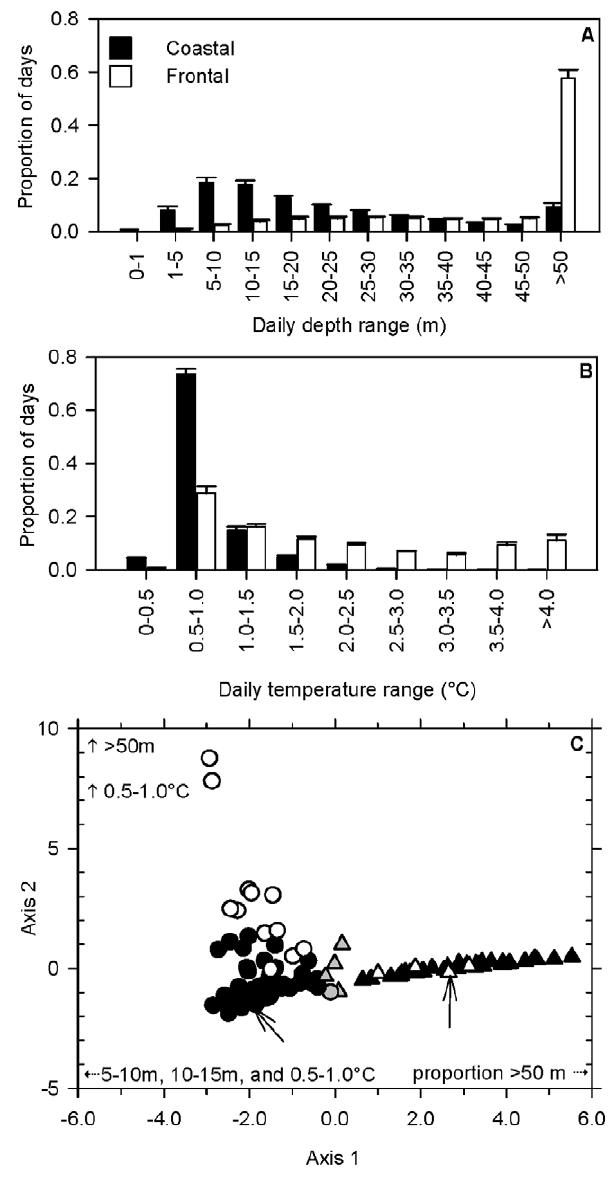
Figure 3. Definition of coastal and frontal behavioral types of Atlantic cod. Mean ( 6 SE) proportion of daily depth (A) and temperature (B) ranges experienced by individuals tagged with electronic data storage tags (DSTs). Discriminant function analysis (C) performed on the proportion of daily depth and temperature ranges experienced by each individual indicated a clear separation between N ) and frontal (northern: n ; southern: the coastal (northern: # ; southern: m ) behavioral types based upon the proportion of depth and temperature ranges. The visual and DFA classifications of the five individuals represented by a gray circle or triangle could not be reconciled and these individuals were excluded from further analysis. Arrows indicate individuals whose depth and temperature profiles are displayed in Fig. 2a and 2b. doi:10.1371/journal.pone.0017528.g003 patterns of coastal and frontal cod seem to be discrete and independent of the position of an individual on an ecological gradient such as depth. The associated differential habitat use separates coastal and frontal cod throughout the year and may be sufficient to isolate the behavioural types during spawning.